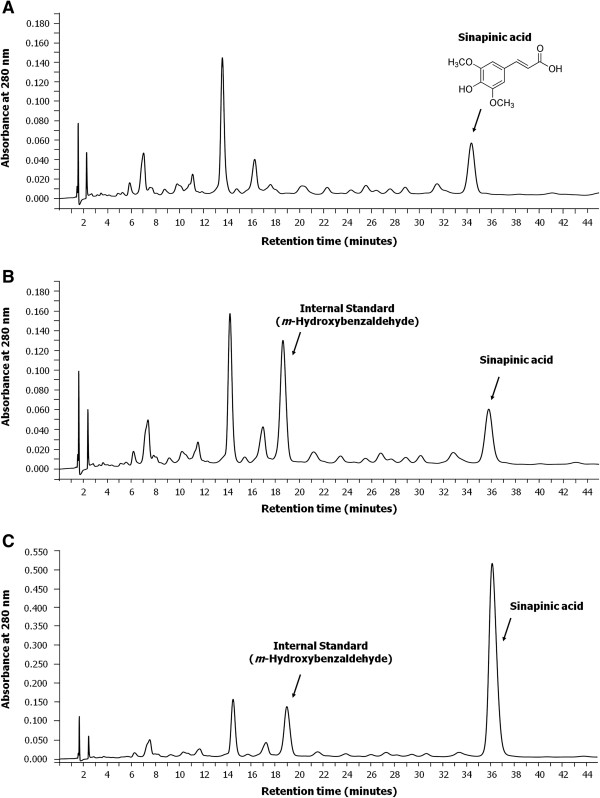
HPLC profiles of phenolic-rich extract from H. formicarum Jack. rhizome. HPLC profiles of (A) phenolic-rich extract alone (180 μg), (B) phenolic-rich extract added with the internal standard, m-hydroxybenzaldehyde (1 μg), and (C) phenolic-rich extract added with the internal standard (1 μg) and the standard sinapinic acid (2 μg), are displayed comparatively. The data shown are representative of two independent experiments performed in duplicate. A phenolic compound, sinapinic acid, is indicated and its chemical structure is depicted.